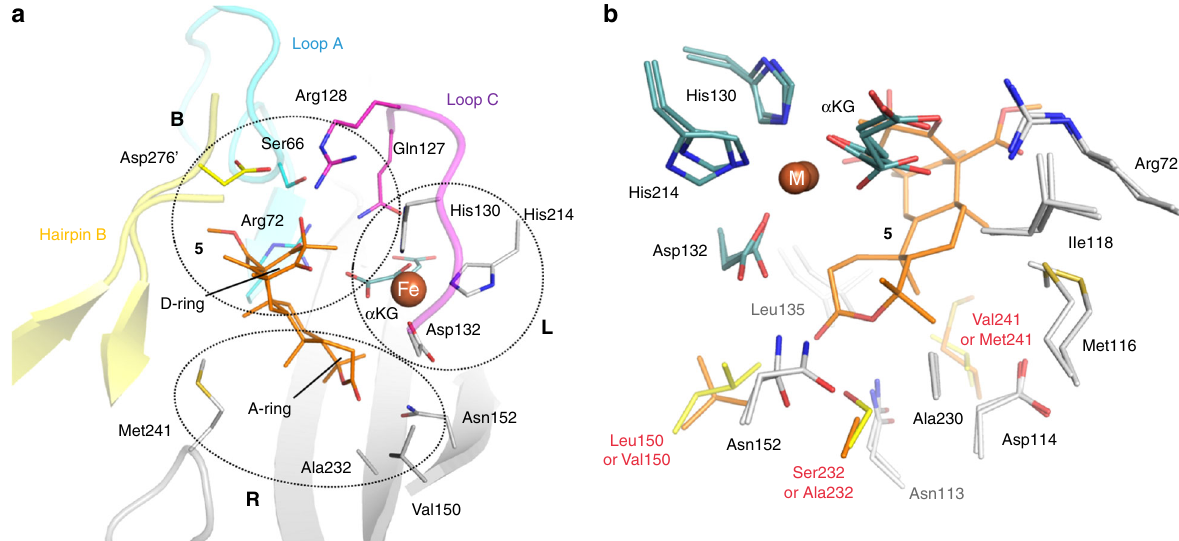
Fig. 2 The active sites of AusE-Mn/ α KG and PrhA-Fe/ α KG/ 5 . a The active site of PrhA-Fe/ α KG/ 5 showing the residues binding the Fe(II) ion and substrate 5 . The active site is separated into three regions. Region L includes the 2-His-1-Asp triad binding Fe(II). Region B includes the residues interacting with the D-ring of 5 . Finally, Region R includes residues surrounding the A/B-ring of 5 . b Comparison of AusE-Mn/ α KG and PrhA-Fe/ α KG/5 active sites. Selected amino acid residues, co-substrate α -ketoglutarate ( α KG, blue) and the substrate 5 (orange) are shown as stick models. Mn(II) or Fe(II) are shown as spheres with the label M. The active site structures of AusE and PrhA are highly similar, except for the three residues (150, 232, and 241) near the A/B- ring of 5 . Residues derived from AusE (Leu150, Ser232, and Val241) and PrhA (Val150, Ala232, and Met241) are colored in yellow and orange,